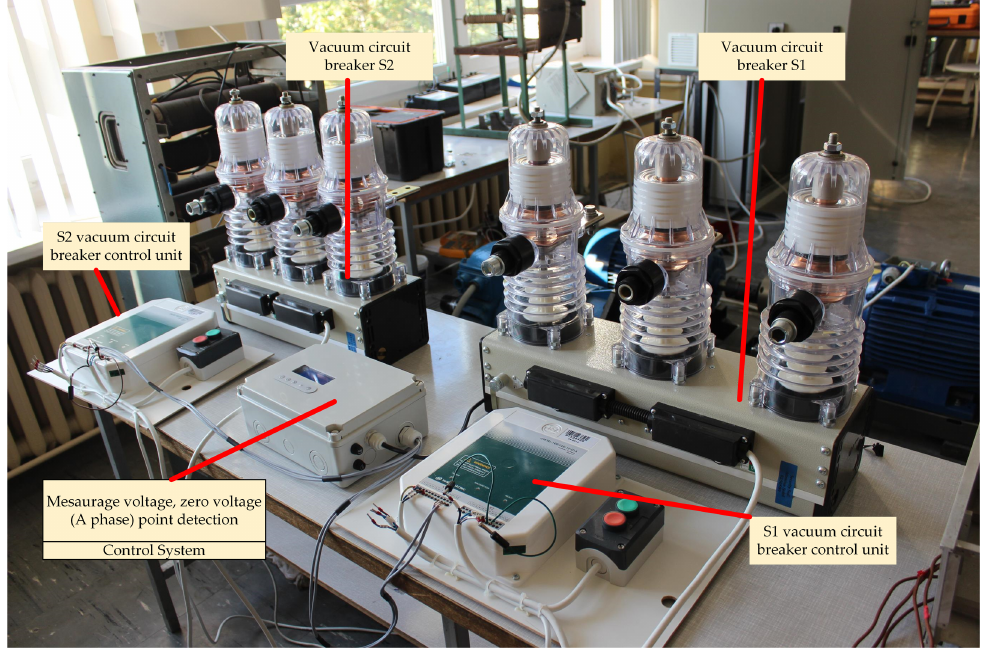
Figure 18. Control system for switching on an induction motor with vacuum circuit